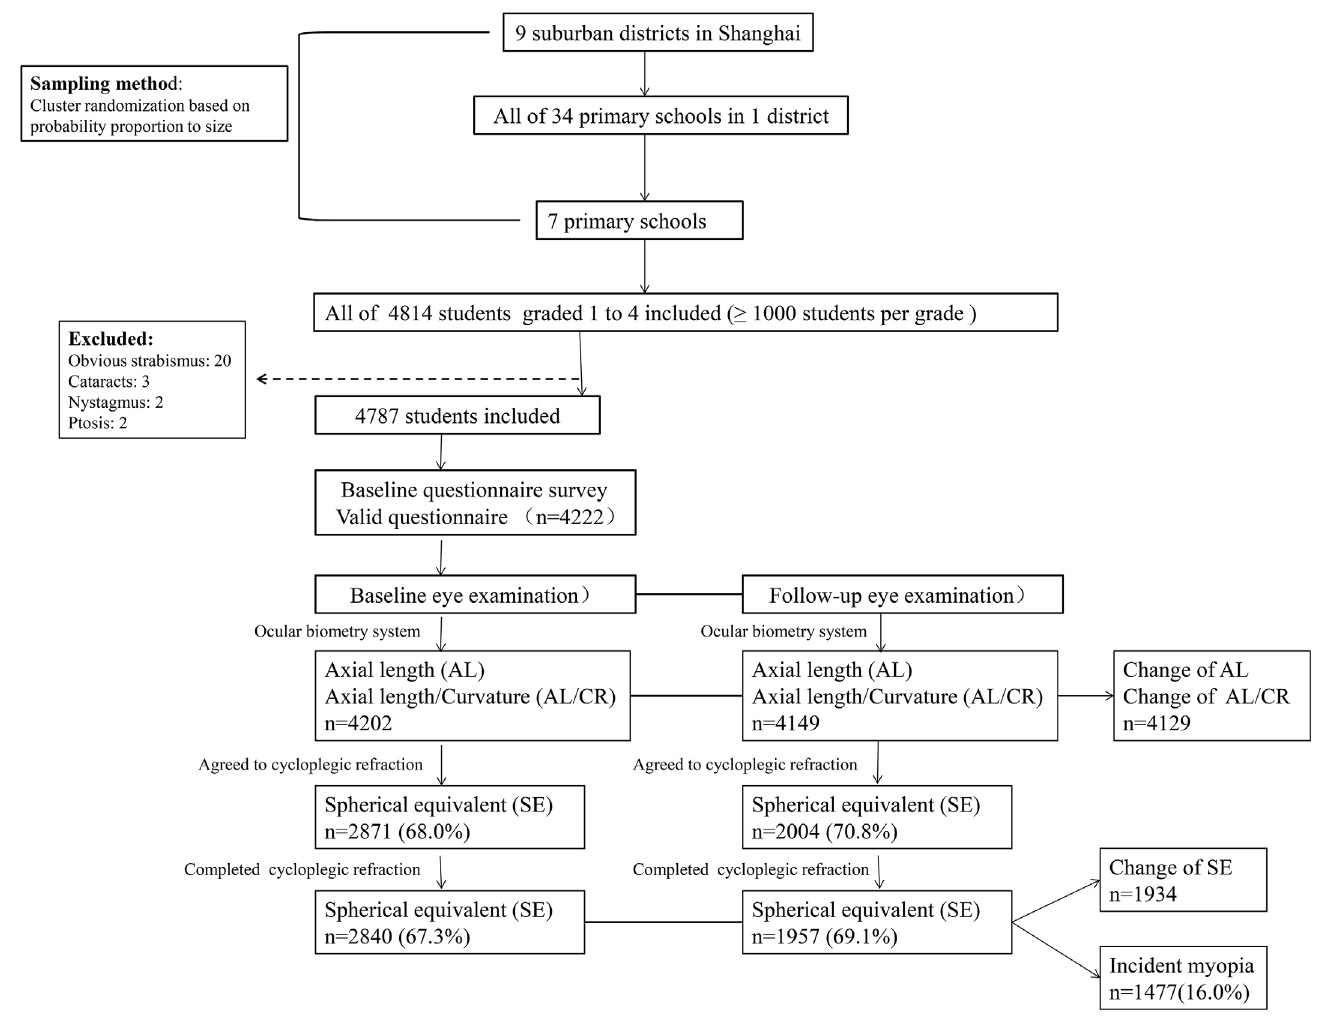
Fig 1. Flow chart of participant